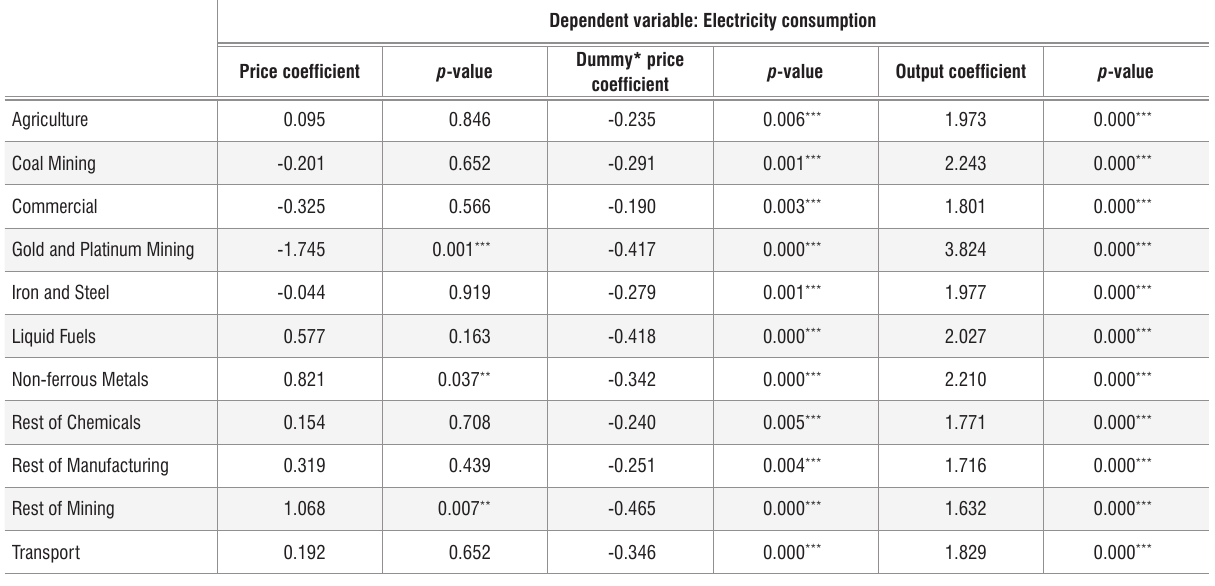
Seemingly unrelated regression estimation